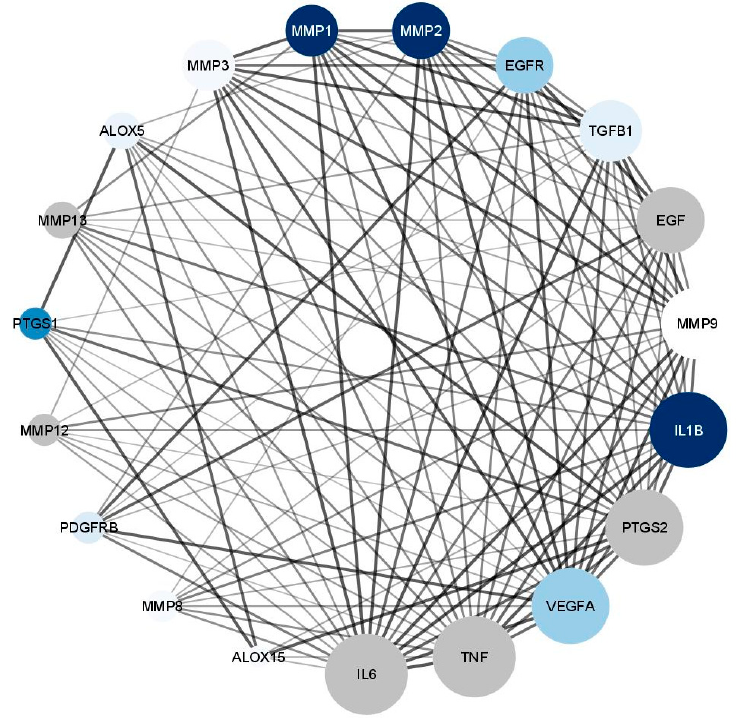
Figure 19. Network nodes represent suggested protein targets, and the edges represent protein– protein interactions. The size of nodes signifies the connectivity of each protein; the higher the node size the higher its connectivity to other nodes; the color fill of the nodes represents the skin tissue expression as the more intense the color the greater the expression. Table 2. Topological parameters of targets combined with skin tissue expression score.